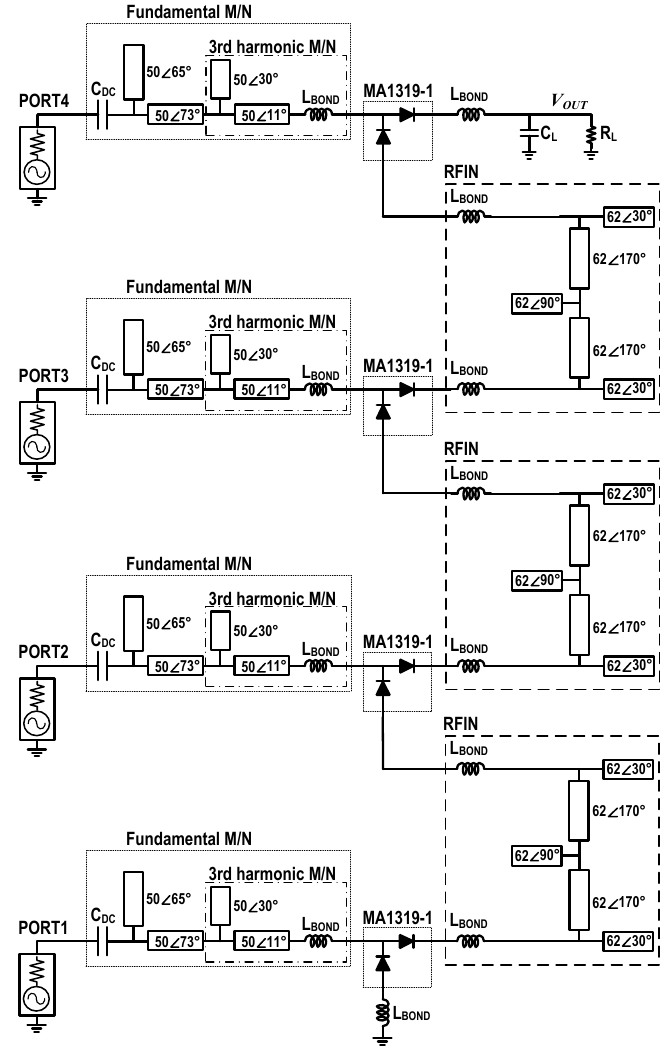
Figure 10. A schematic of the implemented 4-stack RF–DC converter based on class-F voltage